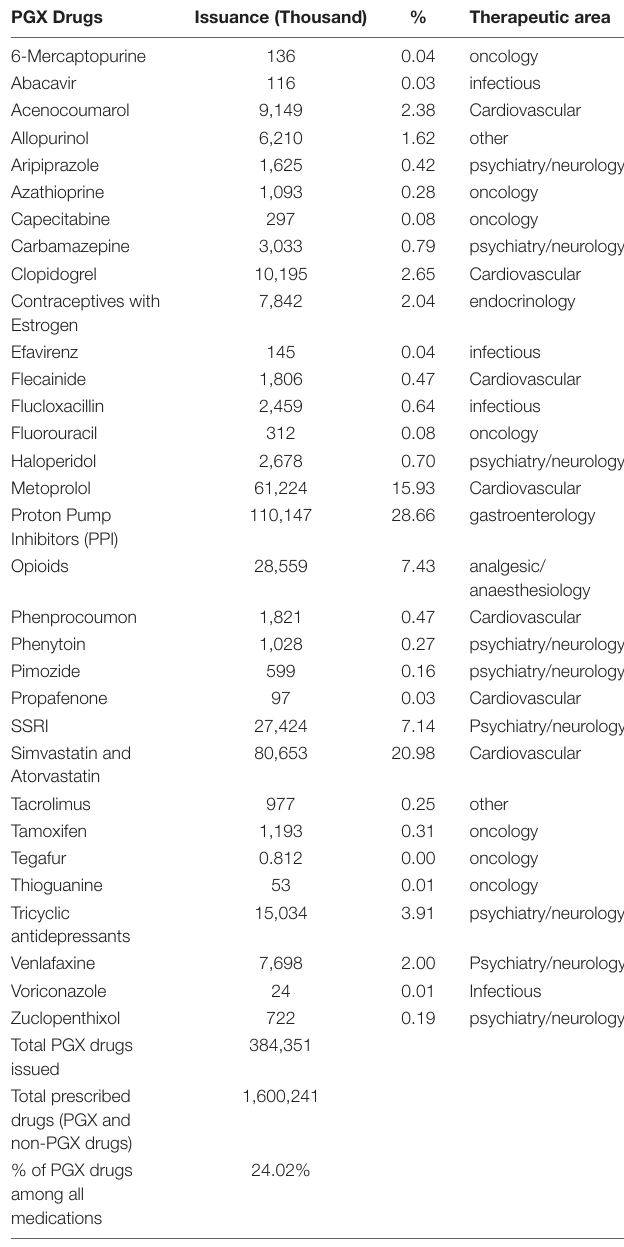
TABLE 3 | Issuance of PGX drugs over 7-year period (2011–2017) in